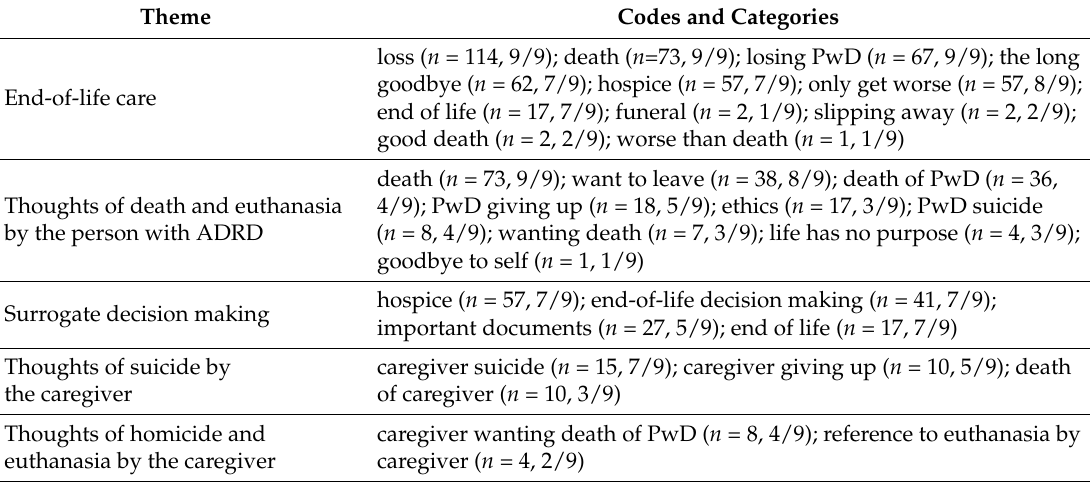
Table 1. Schematic of themes with associated categories and codes. Codes and